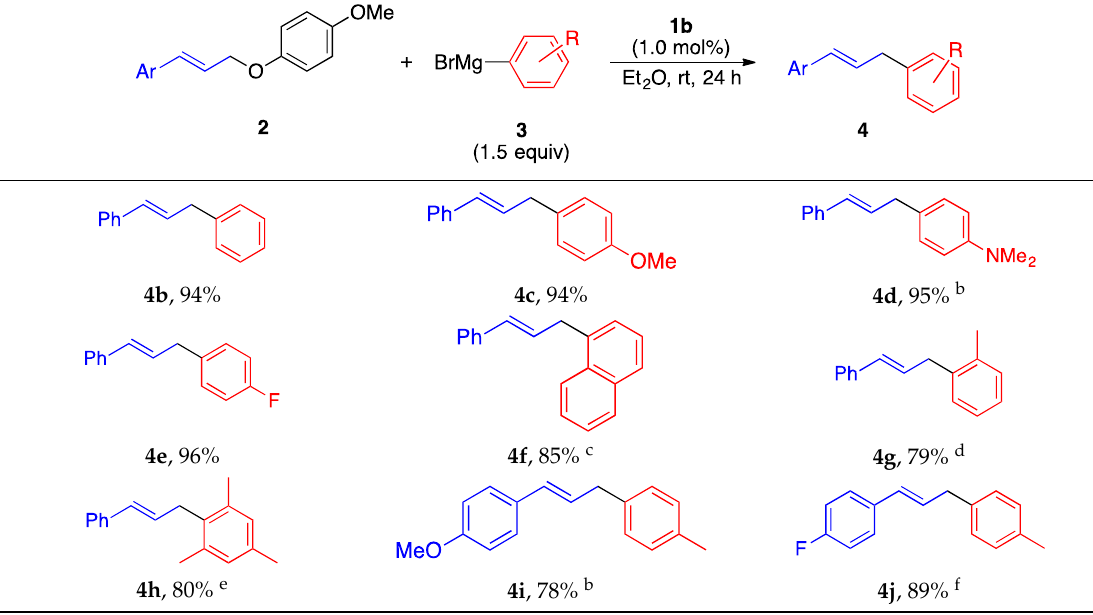
Table 4. The cross-coupling reaction of allylic ethers 2 with arylmagnesium reagents 3 . a